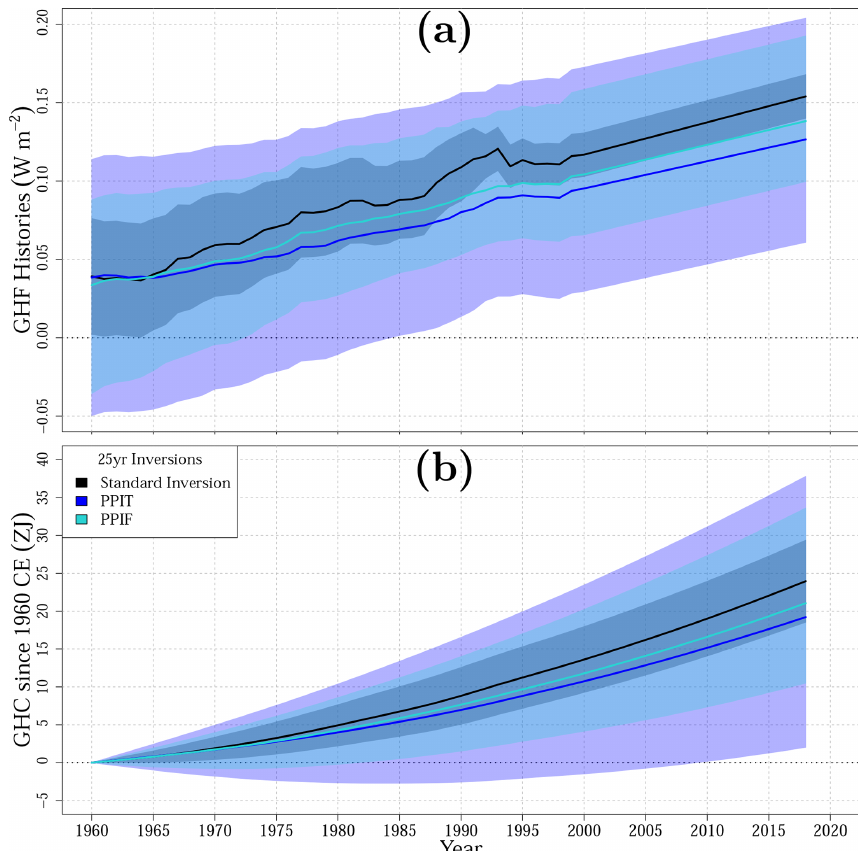
Figure 4. Global ground heat flux histories (a) and ground heat content accumulated since 1960CE (b) from borehole temperature profiles using the standard approach (black) and the new PPI approach applied to temperature profiles (PPIT, blue) and the corresponding heat flux profiles (PPIF, light blue). All inversions were performed using a 25-year inversion model. Data for 2001 to 2018CE are extrapolated using the trend for the period